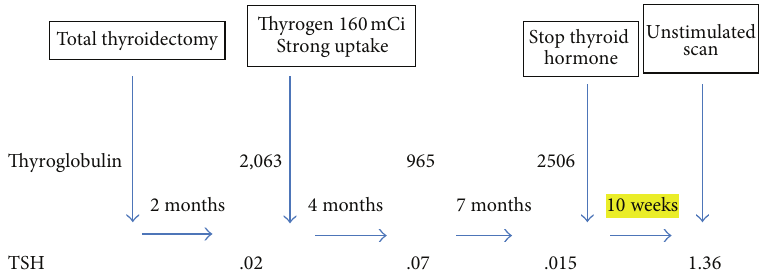
Figure 7: Changes in thyroglobulin and TSH values during course of treatment. Normal values: TSH (thyroid stimulating hormone) 0.34– 5.6 𝜇 IU/mL; thyroglobulin